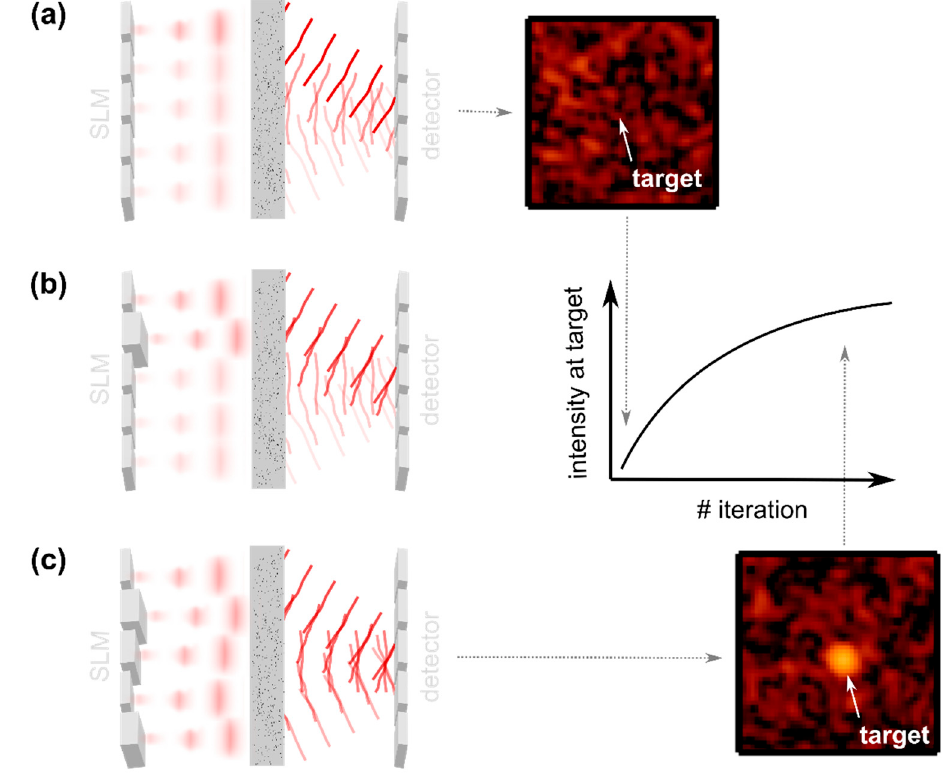
Figure 6. Principle of iterative wavefront shaping. ( a ) A flat wavefront incident on a scattering sample results in a speckle pattern to be observed at a detector placed behind the medium. ( b ) The phase of individual segments of the incident wavefront can be manipulated using an SLM. Due to the linearity of propagation, the phase of the respective contributions to the scattered field shifts accordingly. A high intensity at an arbitrarily chosen target at the detector is observed if a high number of field contributions match in phase at this position. The wavefront shaping algorithm iteratively optimizes the phase pattern applied to the incident beam such that the intensity at the target is maximized. ( c ) A high-intensity focal spot on top of a speckle pattern results with the final optimized wavefront. Image from [8], with